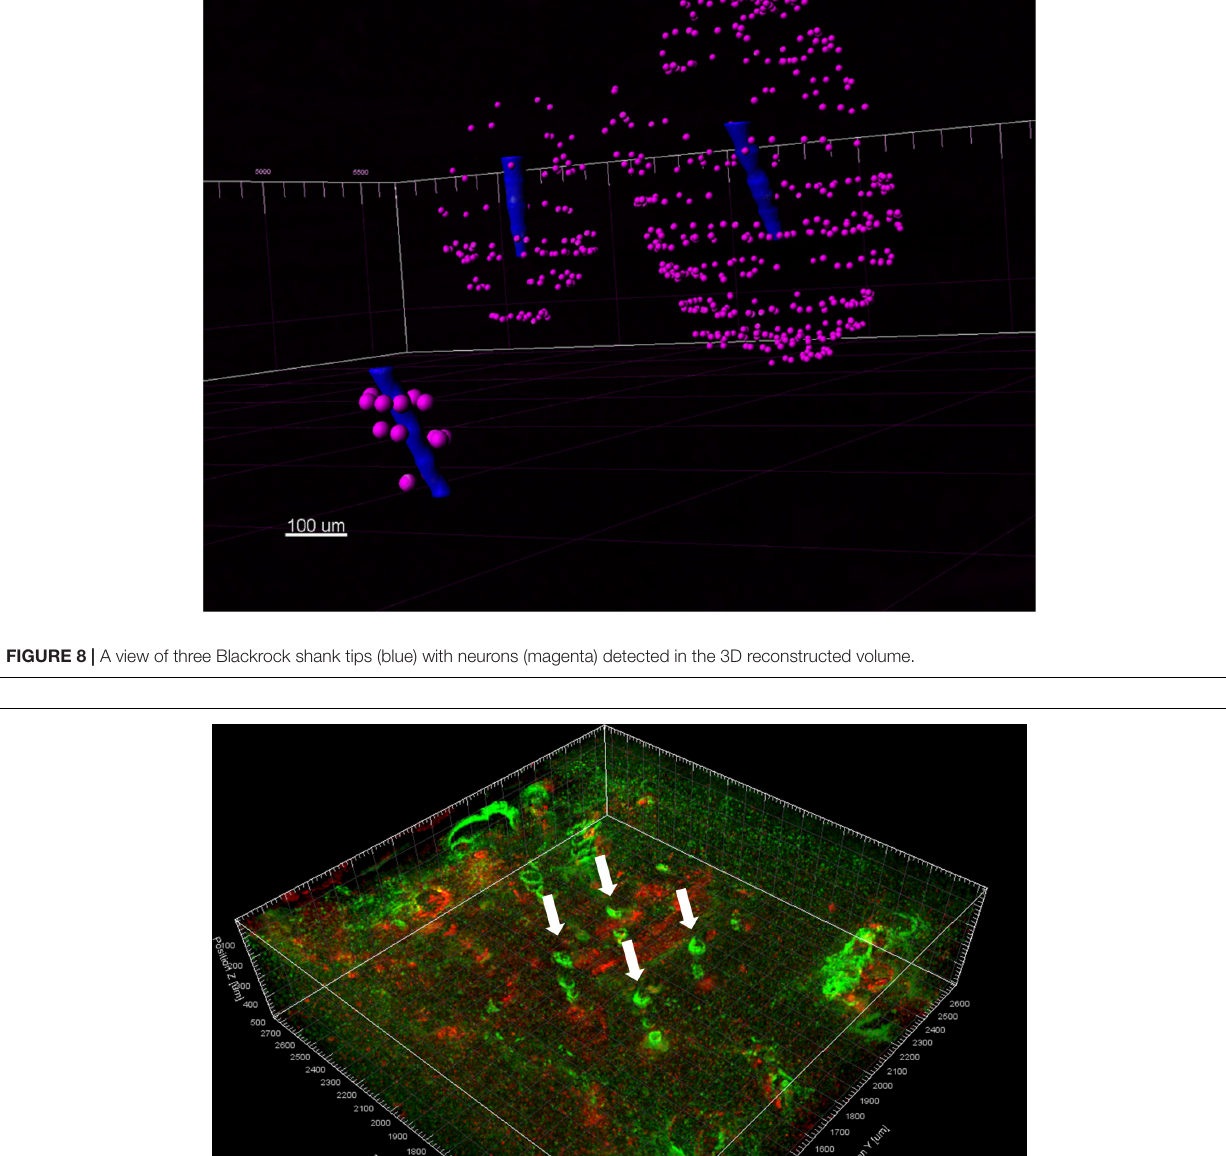
To evaluate the consistency of manual alignment across users, the alignment rotations and translations of two users were compared. When each user performed the alignment